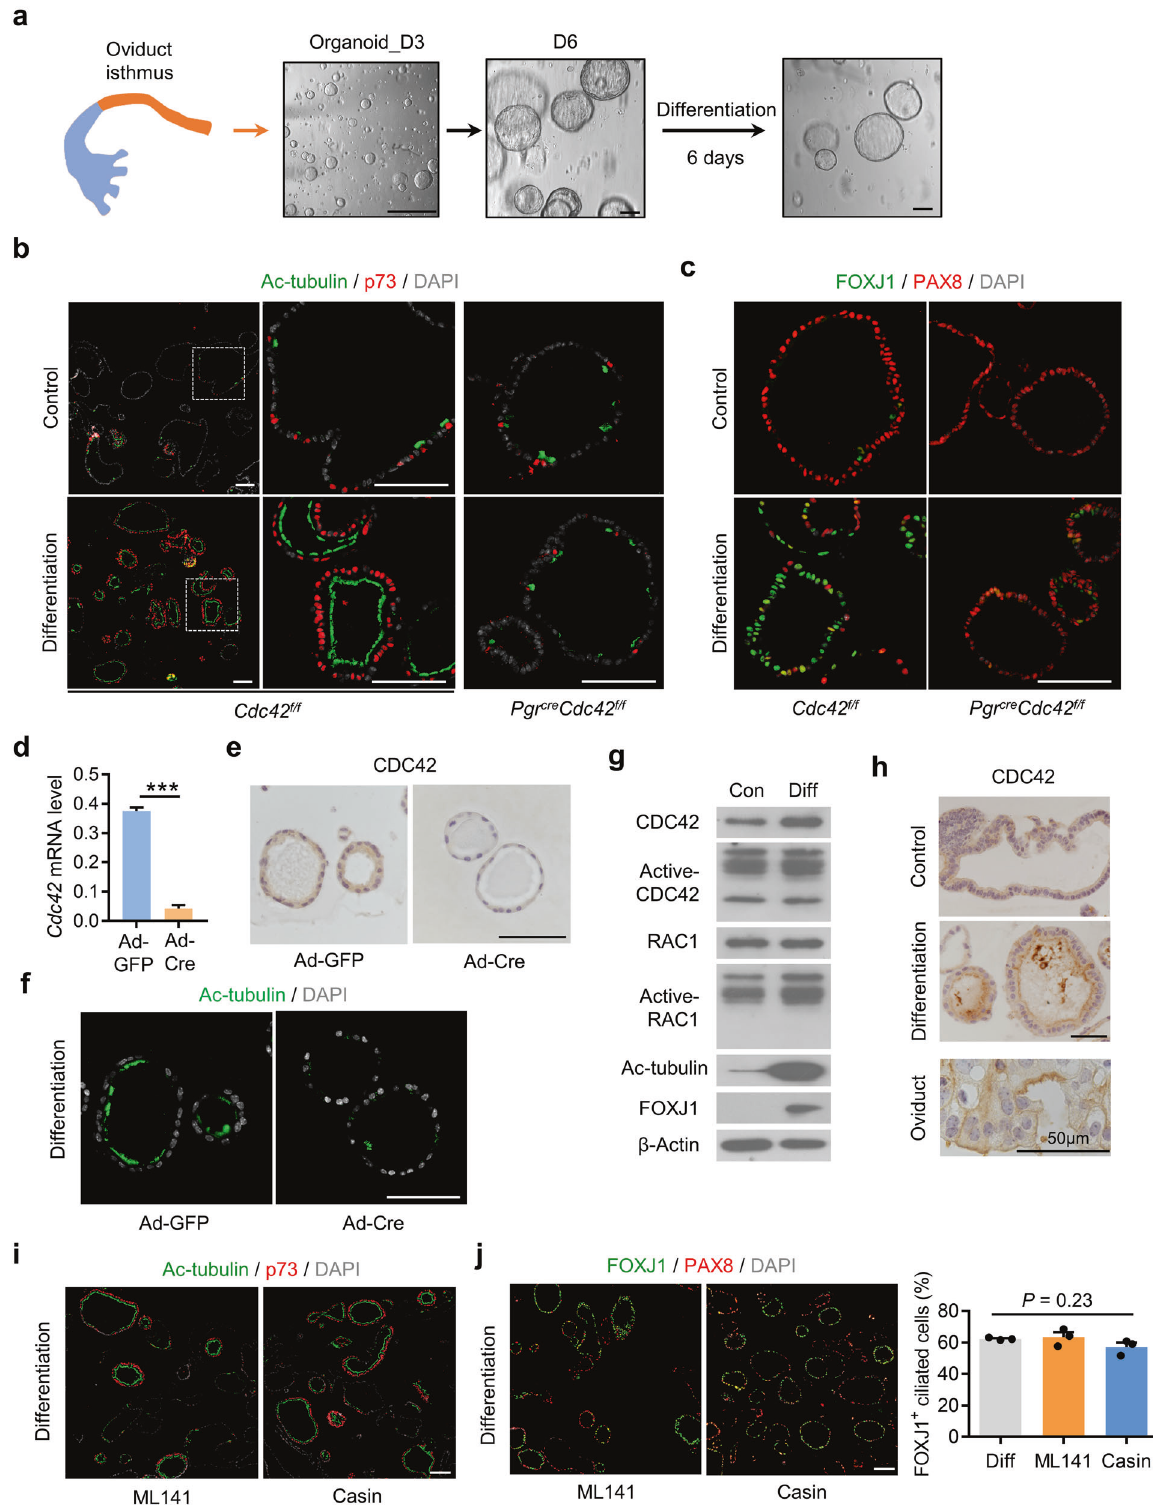
intracellular domain (NICD2) were decreased obviously in Pgr cre Cdc42 f/f mouse oviducts than that in the control (Fig. 4c). Some NICD1 positive epithelial cells were found in the isthmus of Cdc42 f/f mouse oviducts, but were rarely observed in the isthmus of Pgr cre Cdc42 f/f mouse oviducts (Fig. 4d). Similarly, the